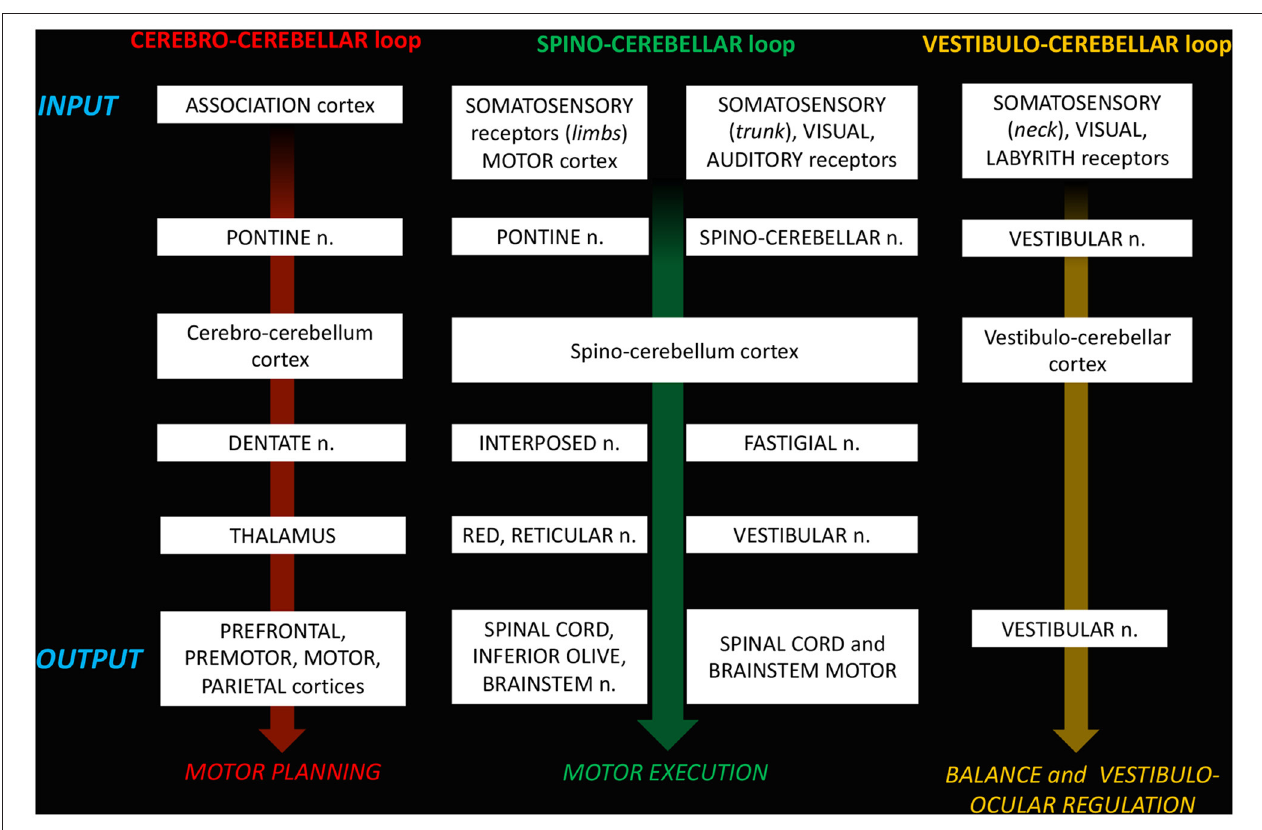
FIGURE 3 | Schematic representation of the loop-organization of cerebellar